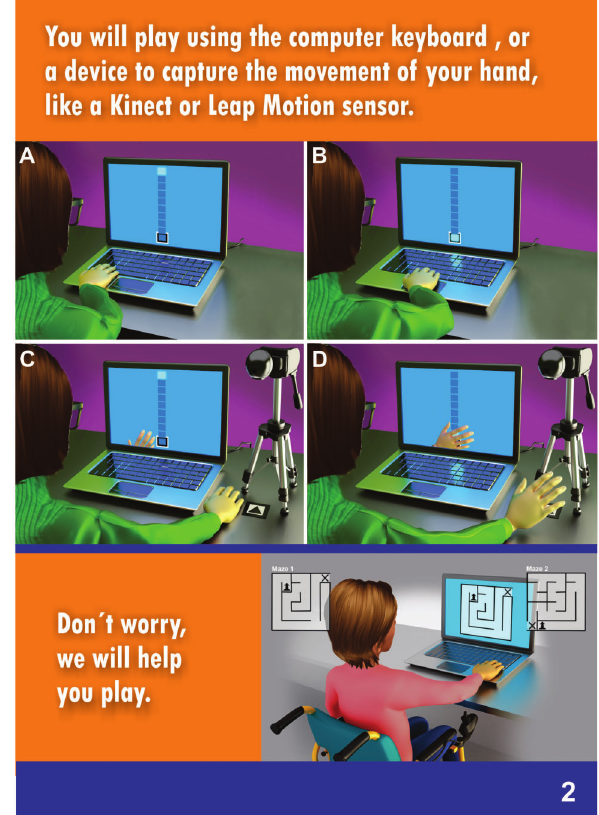
Figure 3A - Model of assent - Part A.